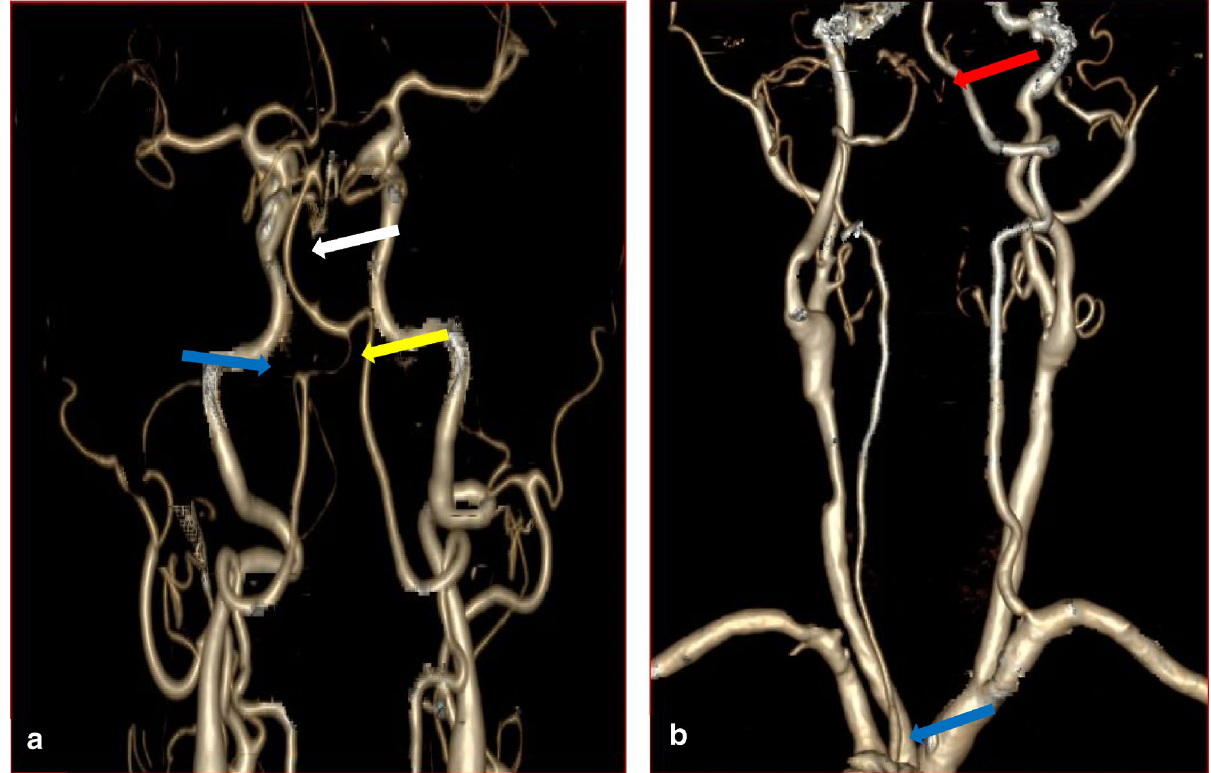
Figure 2. 3D-CTA reconstructed images showing the vertebral, the subclavian, and the carotid arteries. ( a ) The blue arrow indicates PICA. The yellow arrow indicates hypoplastic terminal VA while the white arrow indicates the bending basilar artery. ( b ) The blue arrow illustrates the origin of the left VA from the arch of the aorta, and the red arrow shows the termination of ipsilateral VA as